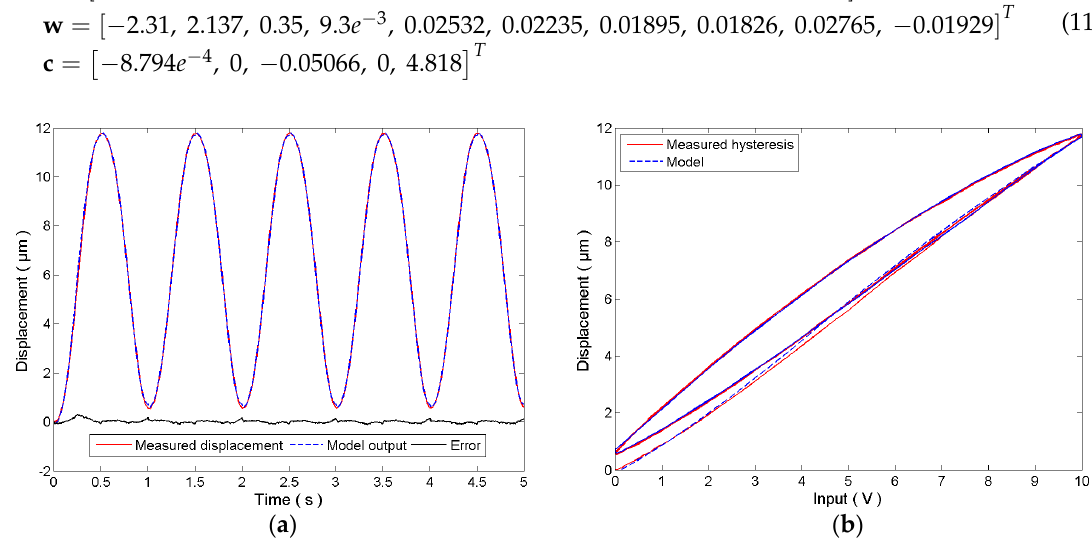
Figure 3. Identification of the rate-independent hysteresis model using a 1 Hz sinusoidal signal: ( a ) time plot and ( b ) hysteresis plot.